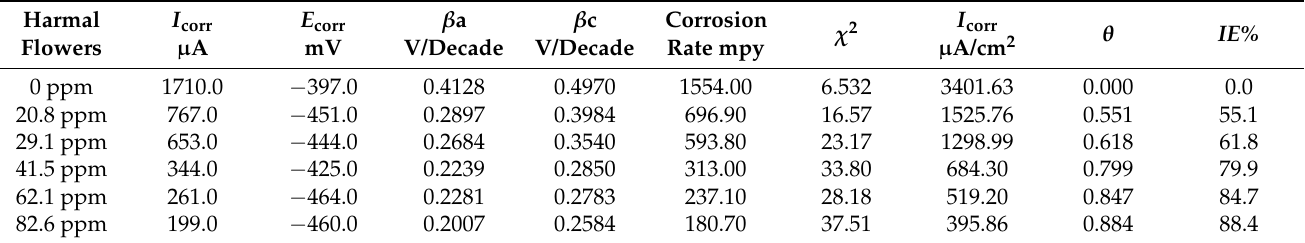
Table 10. Polarization parameters for various concentrations of Harmal flower extract on the